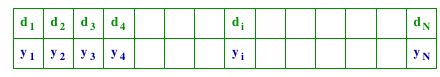
Figure 5. Vector of evaluated decisions.